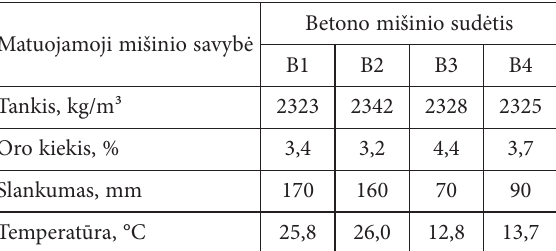
5 lentelė. Technologinės betono mišinių savybės Table 5. Technological properties of concrete mixtures Matuojamoji mišinio savybė